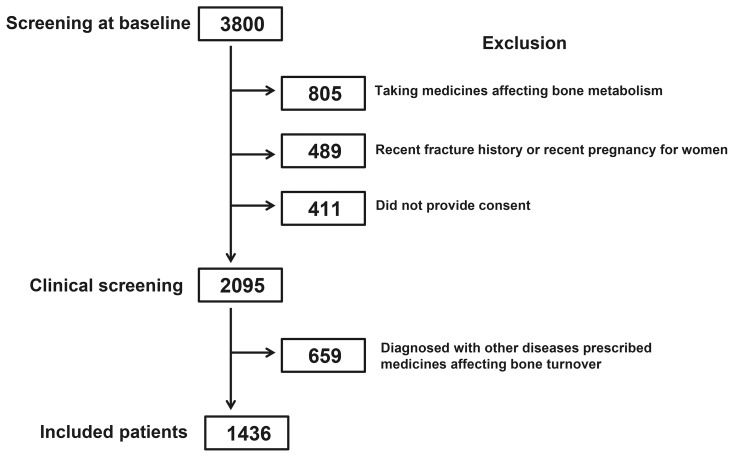
Subject screening and recruitment.